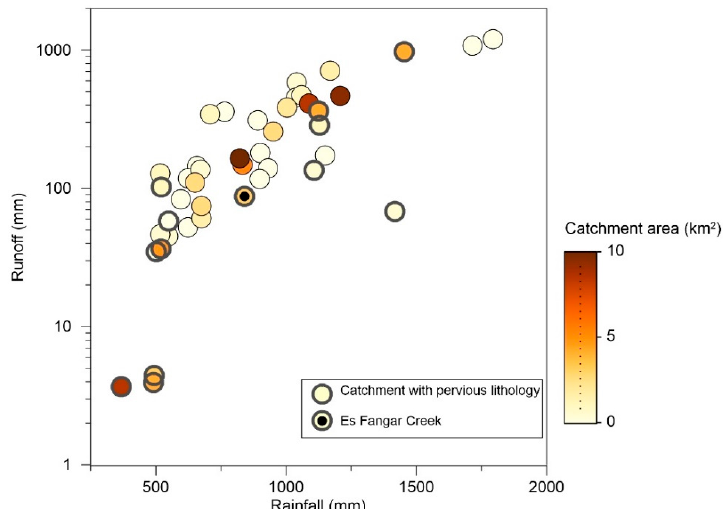
Figure 2. Rainfall-runoff for 43 small Mediterranean-climate catchments at the annual scale. Catchments with pervious lithology are marked with a grey halo. The Es Fangar Creek value is illustrated with a black dot.